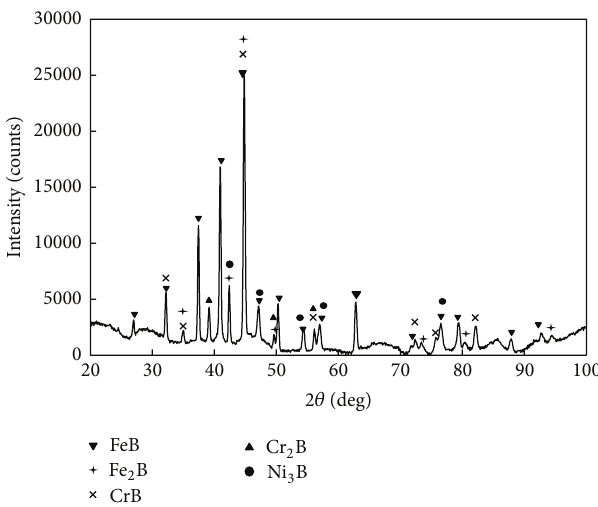
Figure 5: XRD pattern of AISI 316L steel borided for 6 h at a temperature of 1273 K and an inner diameter of the sample of the 6.35 mm (sample 3).